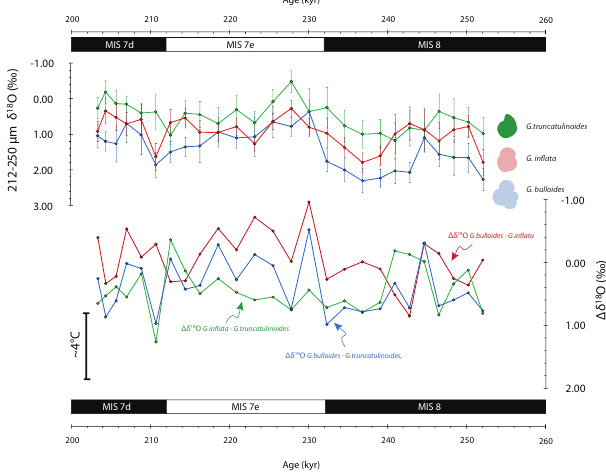
Figure 12. Oxygen isotope of smallest size fraction and differences. (a) The oxygen isotopes between small-sized specimens of G. bul- loides , G. inflata and G. truncatulinoides and (b) the calculated dif- ference between species ( (cid:49)δ 18